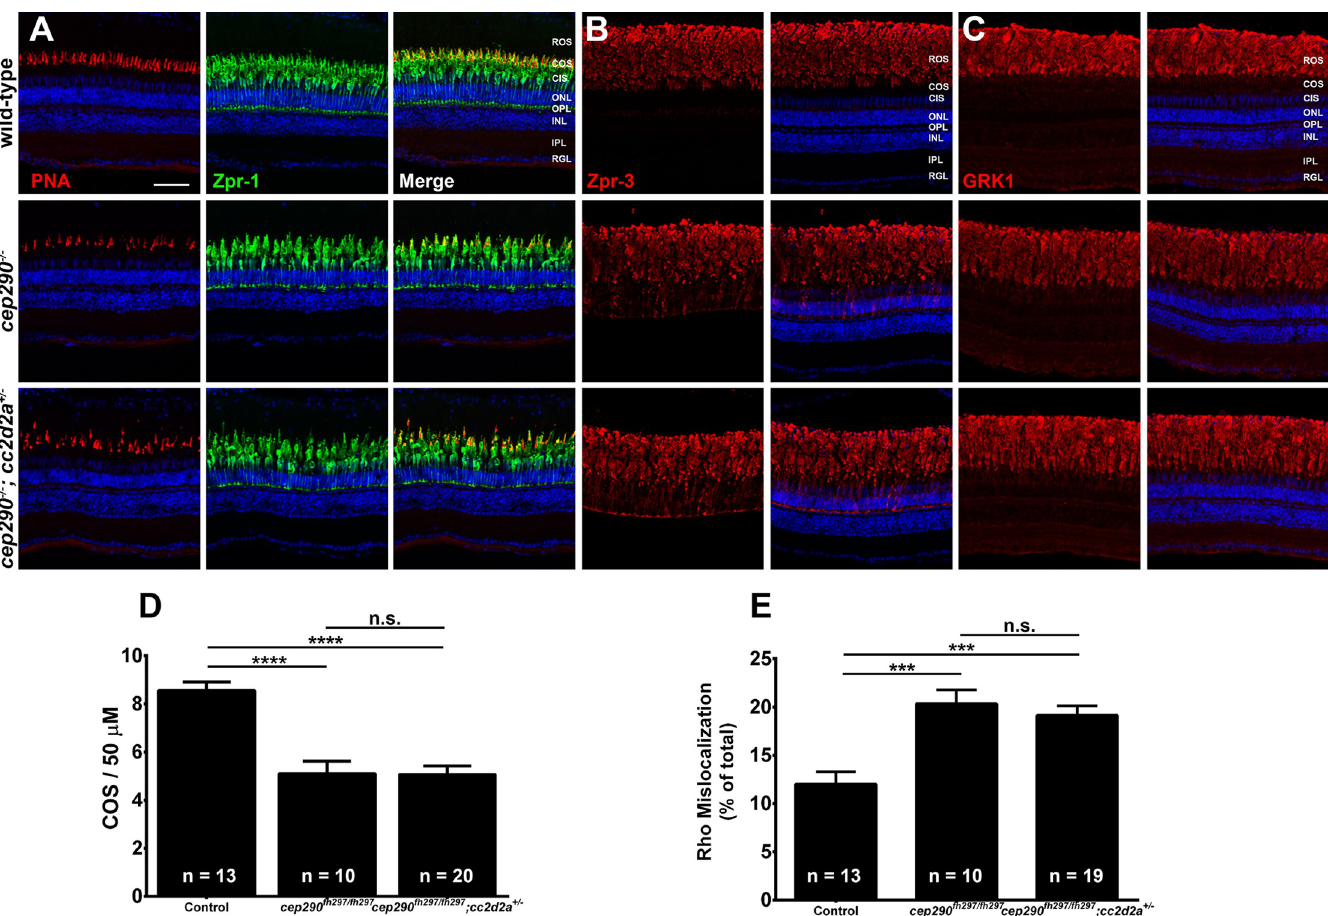
Fig 10. Combined loss of cep290 and cc2d2a does not exacerbate cone degeneration or rhodopsin trafficking defects. Panels show immunohistochemical analysis of dorsal retinas from wild-type (top), cep290 fh297/fh297 (middle), and cep290 fh297/fh297 ;cc2d2a +/- mutants (bottom) at 6 months of age stained with (A) PNA (red) and Zpr-1 (green) to label cone photoreceptor; (B) Zpr-3 to label rhodopsin; or (C) GRK1 to label rhodopsin kinase. ROS, rod outer segments; COS, cone outer segments; ONL, outer nuclear layer; OPL, outer plexiform layer; INL, inner nuclear layer; IPL, inner plexiform layer; RGC, retinal ganglion cells. Scale bar: 50 μ m. (D) Quantification of cone outer segment density or (E) rhodopsin mislocalization from the indicated genotypes at 6 months of age. See methods section for details on quantification. Removing one allele of cc2d2a from a cep290 fh297/fh297 mutant background had no effect on cone degeneration or rhodopsin mislocalization. At least 10 unique fish over at least 2 independent experiments were evaluated. ��� P < 0.0005; ���� P < 0.0001 as determined by a 1-way ANOVA with a Multiple Comparisons test and Tukey corrections. Data represented as means ± s.e.m.